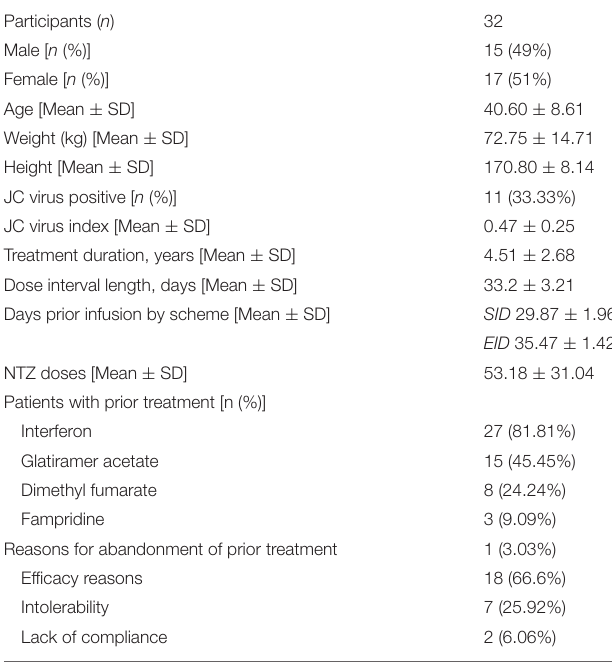
TABLE 1 | Patient demographic and clinical